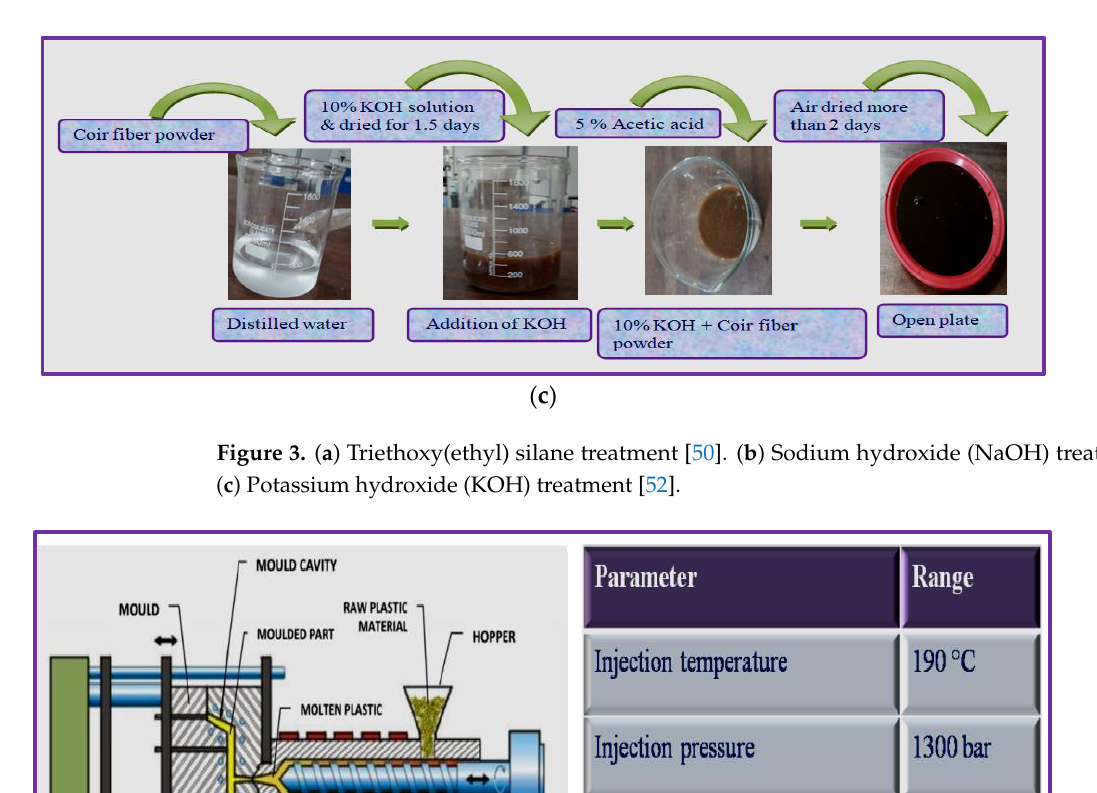
Figure 3. ( a ) Triethoxy(ethyl) silane treatment [50] . ( b ) Sodium hydroxide (NaOH) treatment [51]. ( c ) Potassium hydroxide (KOH) treatment [52].